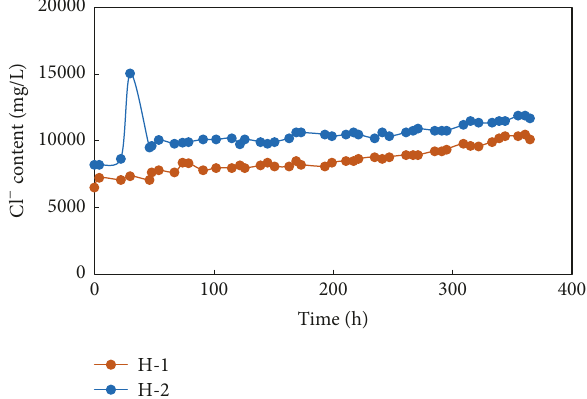
Figure 10: Postfracturing production rate for H1 and H2.